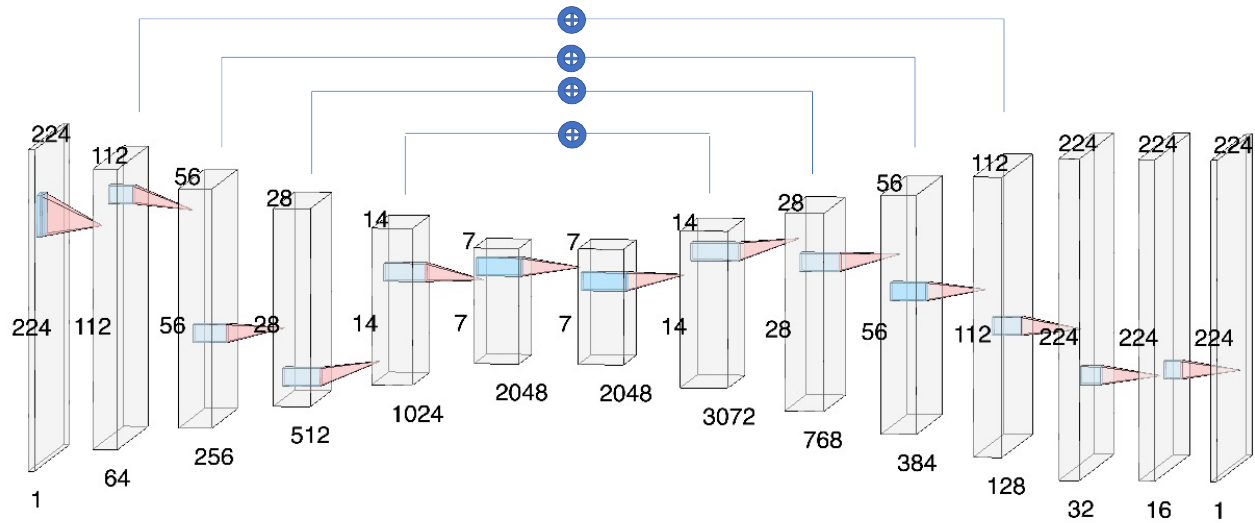
Figure 3. Representation of U-Net with ResNeXt-50. The blue lines above represent skip connections between feature maps. The number of channels in each decoder block is calculated by adding the output channels of the feature map from the encoder with the output channels of the feature map of the normal U-Net